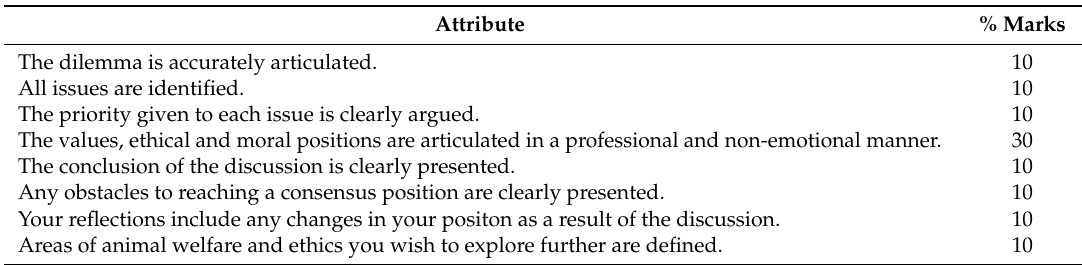
Table 1. Suggested framework for student assessment of the VHC exercise. Attribute % Marks The dilemma is accurately articulated.